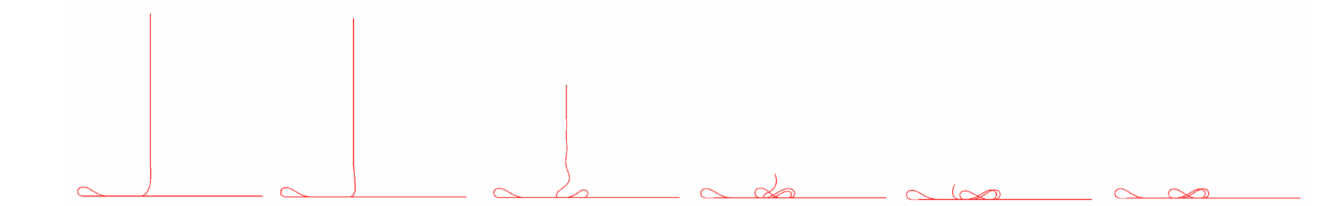
Figure 4. Configuration of a cable with the analytic catenary calculation